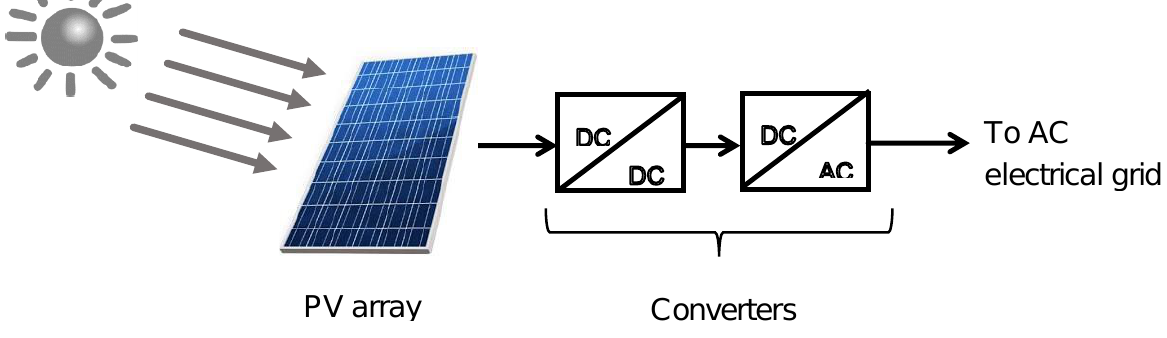
Figure 1. Structure of the system.